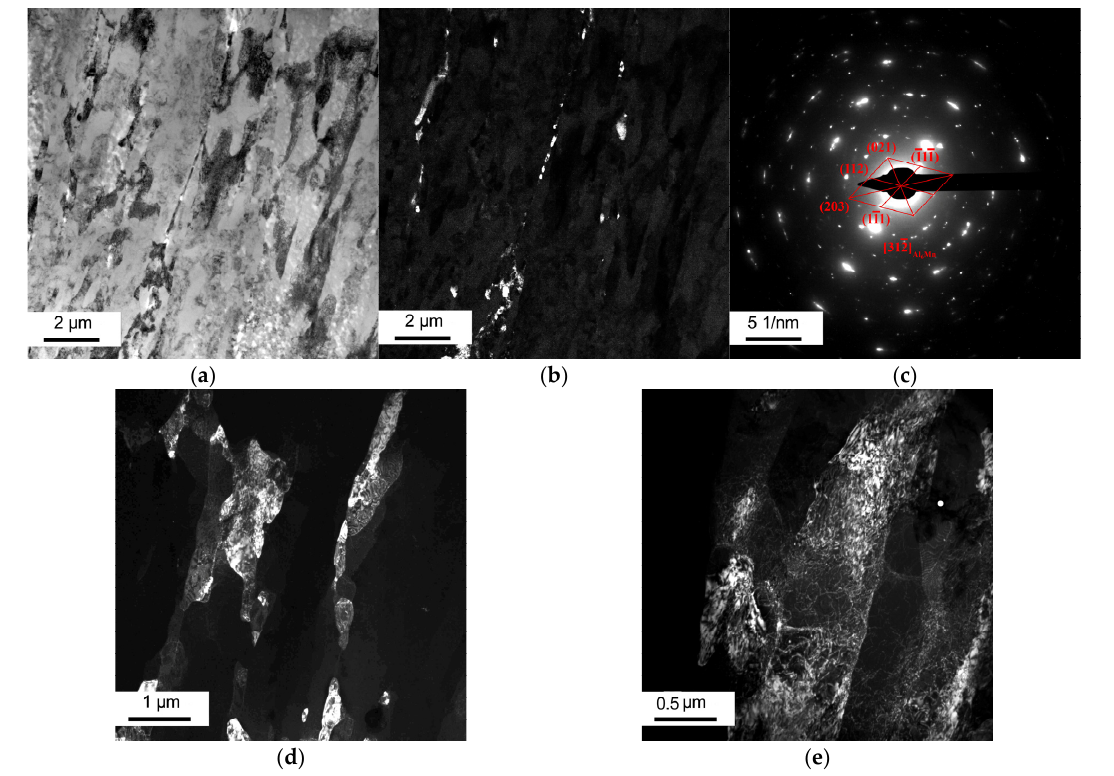
Figure 8. AlMnGr composite microstructure after DCAP: bright-field image ( a ) and dark-field images ( b , d , e ) ( b ) in (311) Al6Mn reflection and ( d , e ) in (111) Al reflections; electron diffraction pattern with Al 6 Mn reflections ( c ), 312 zone axis. Table 2. Characteristics of the fine-structured